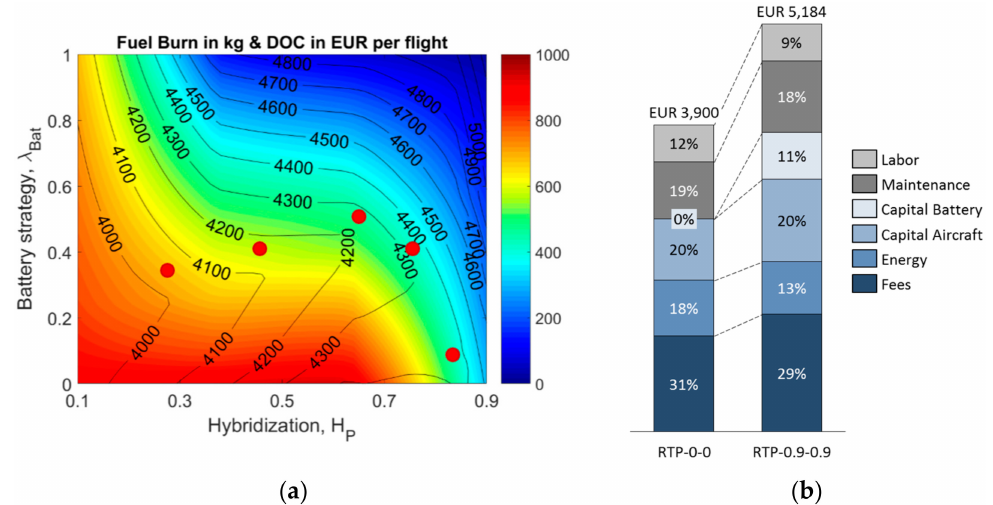
Figure 6. Figures of merit in case of Battery 2 (0.65 kWh/kg, 1 kW/kg): ( a ) Fuel burn in kg (heat map) and DOC per flight (contour lines); ( b ) DOC for RTP-0-0 and RTP-0.9-0.9.